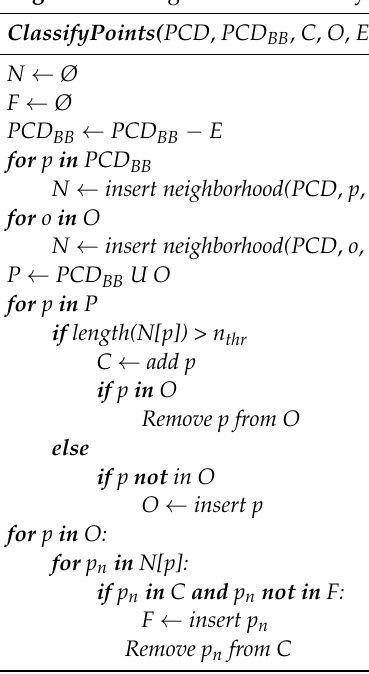
Algorithm 2. Algorithm for Classifying Points into: Core, Outlier and